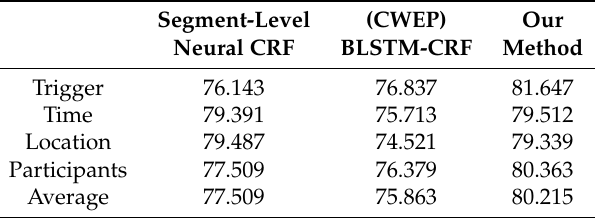
Table 4. F-measure of each event argument.